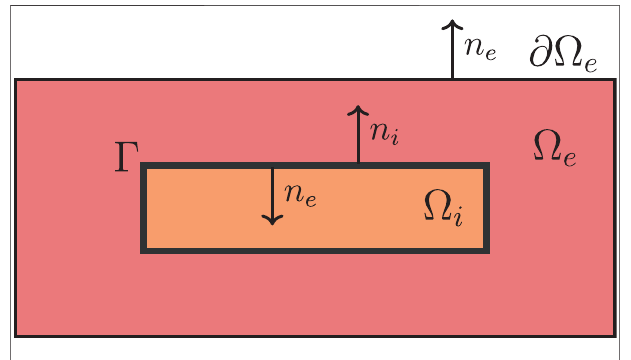
FIGURE1| Illustrationofatwo-dimensionalversionofthedomainforthe EMI model for a single cell. The domain consists of an intracellular domain, Ω i , surrounded by an extracellular domain, Ω e . The membrane, Γ , is de fi ned as the boundary between the intracellular and extracellular domains. The fi gure is reused from Ref. 47 with permission from the publisher.